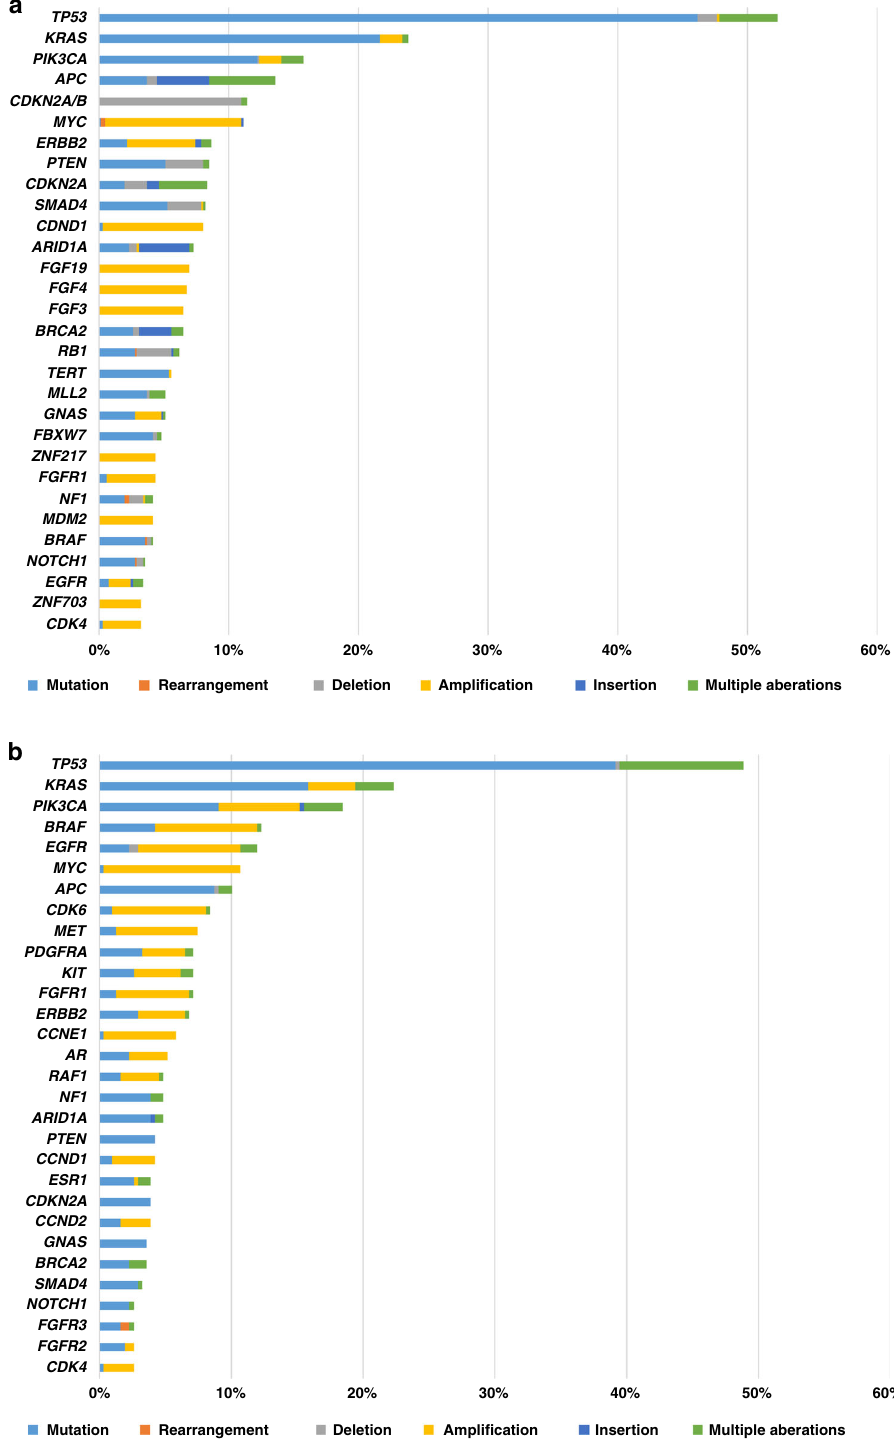
Fig. 1 Frequency of characterized genomic alteration from tissue NGS and cfDNA. a Frequency of characterized genomic alterations by tissue